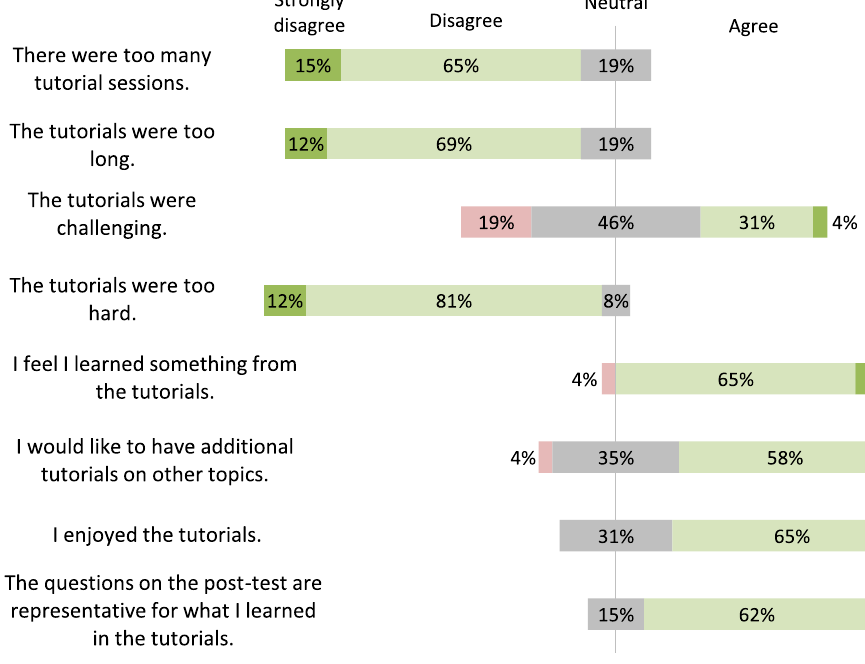
FIG. 15. Student ( N ¼ 29 ) responses to eight 5-point Likert scale questions, evaluating their experiences with the